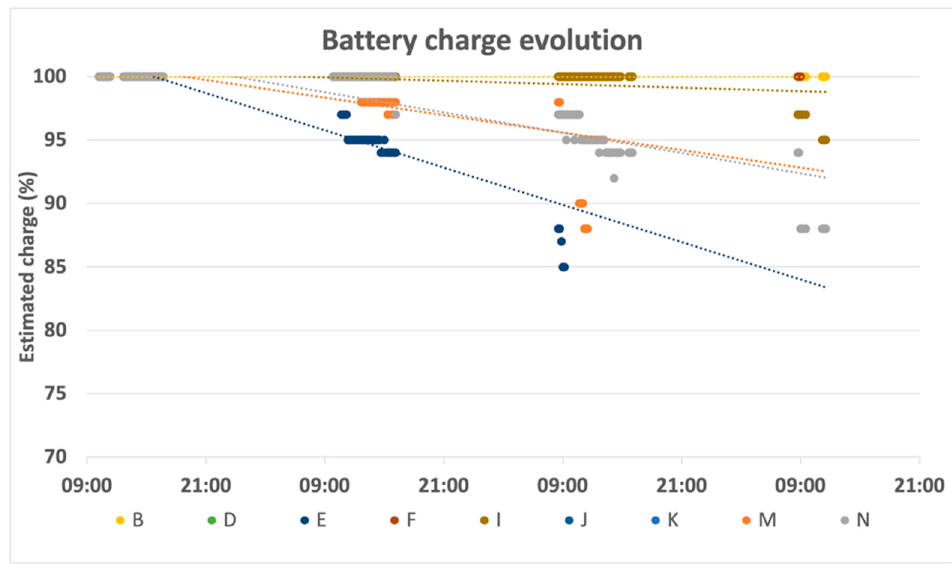
Figure 15. Collar battery-level